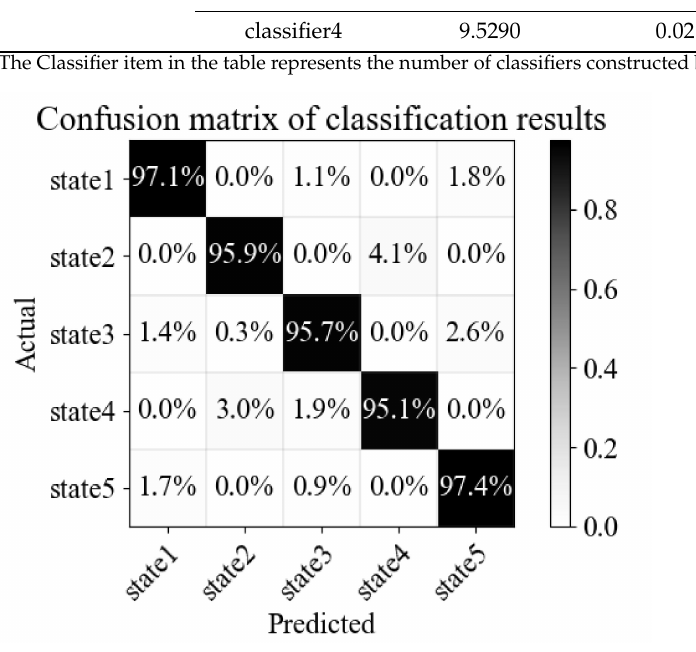
Figure 7. Confusion matrix of classification